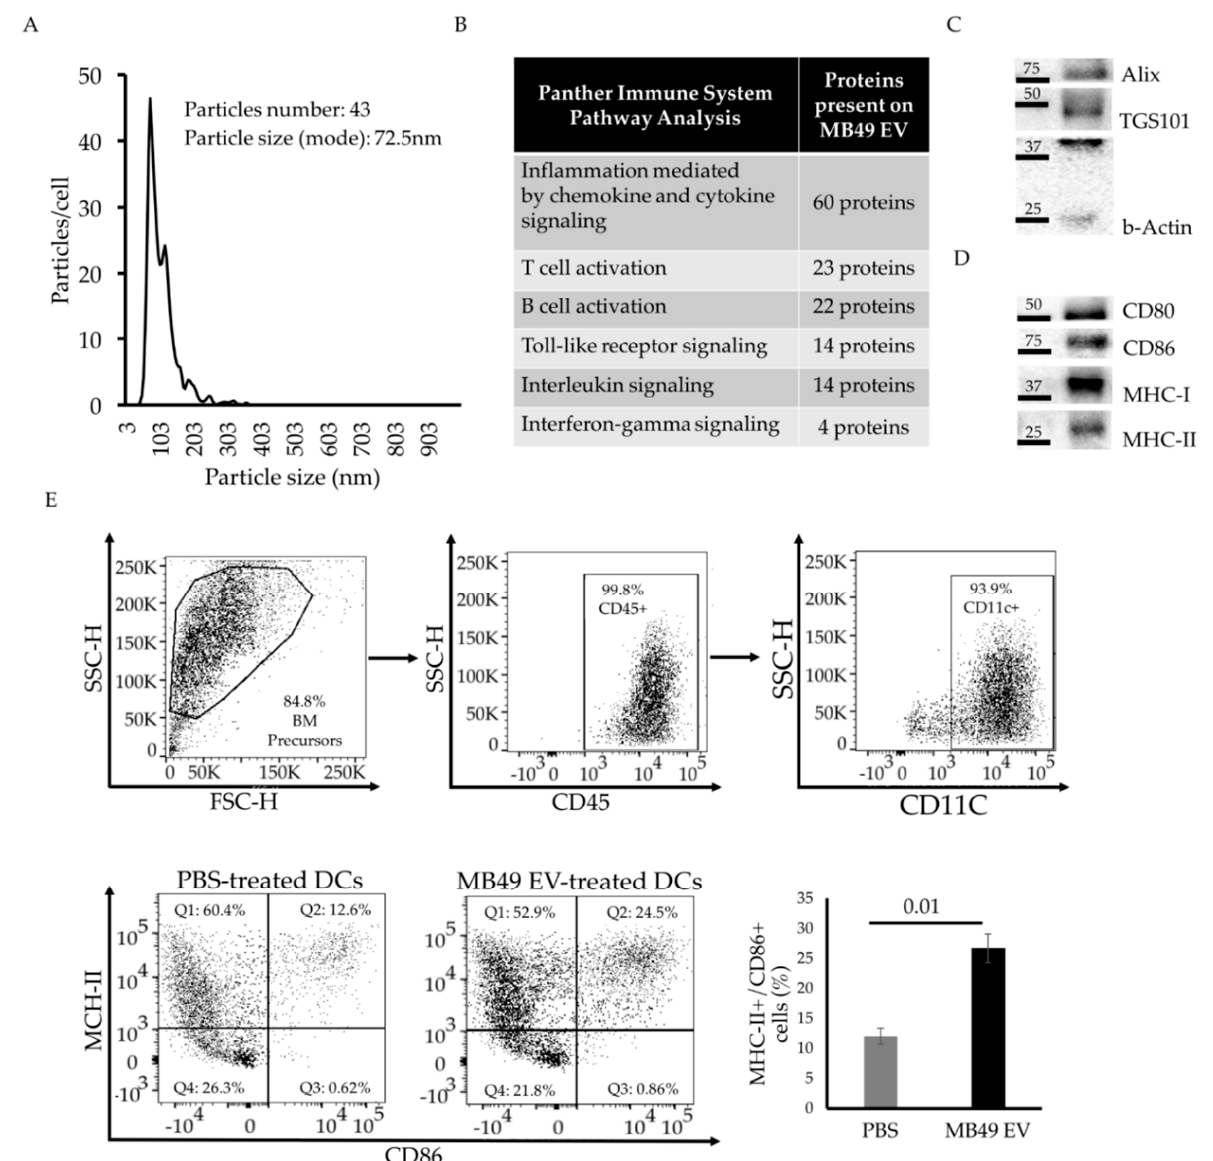
Figure 1. MB49 EVs contain key immunoregulatory cargo proteins and activate BMDCs. ( A ) Historam graph of number of released MB49 EVs per cell and their size (nm) estimated by Nano-particle Tracking Analysis. ( B ) Graph for the identified pathway hits using Panther database of MB49 EV protein cargo identified by Mass Spectrometry Analyses. Table listing identified immune system-related pathways and the number of proteins present on MB49 EVs for each of them. ( C , D ) Western blotting analysis of MB49 EVs targeting common EV markers and validating immune-related cargo proteins presence. ( E ) Gating strategy to show purity level of Bone Marrow-derived DCs in vitro differentiation and activation level changes (MHC-II and CD86) after MB49-EV treatment in vitro; quantification shown in bar graph. Error bars show standard deviation. Statistical significance was calculated by paired independent Student t -test.